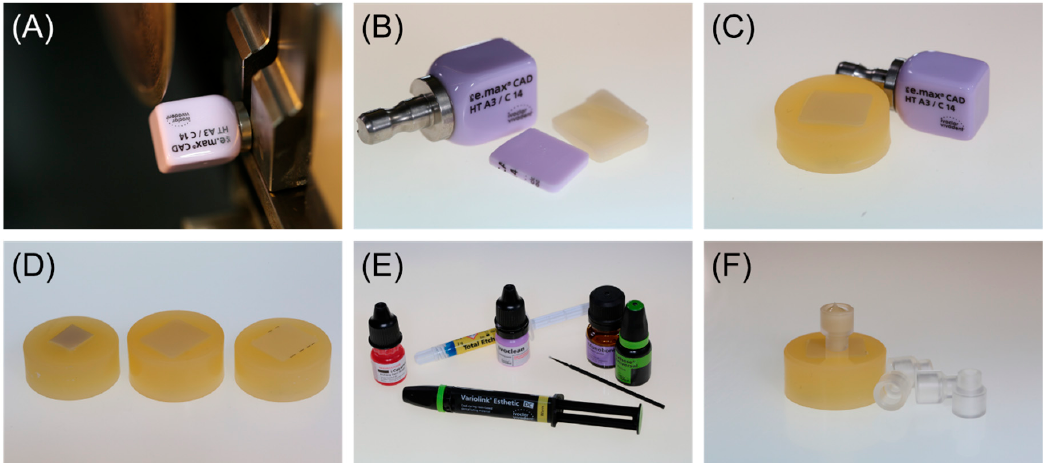
Figure 2. Step by step procedure of specimen preparation with ( A ) cutting of plate-shaped specimens with a cross section of 12.4 × 14.5 mm (lithium disilicate ceramic) and a thickness of 1.5 mm from CAD / CAM blocks using an automated cutting machine; ( B ) plate-shaped lithium disilicate specimens before and after crystallization; ( C ) embedded lithium disilicate ceramic specimen after polishing; ( D ) overview of all tested CAD / CAM specimens after application of cleaning protocols; ( E ) materials used for surface pretreatment and bonding with resin composite cement; and ( F ) acrylic cylinder bonded to specimen surface using resin composite